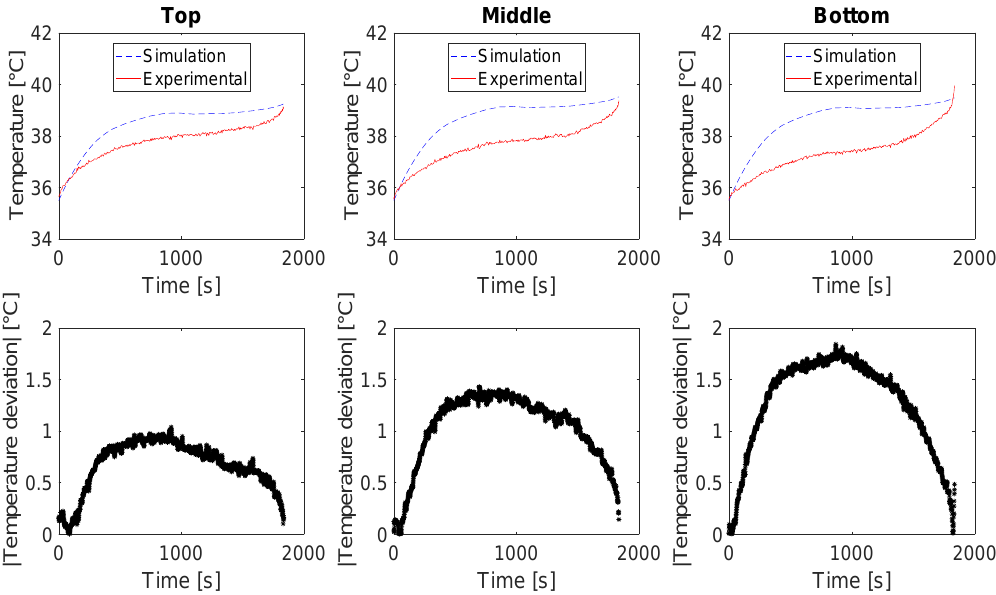
Figure 21. ( Upper ) Uncycled cell surface temperature at three different locations (Top, Middle, Bottom) during high constant current discharge at 35 ◦ C cycling temperature; ( Lower ) Corresponding absolute value of the temperature deviation between experimental and simulations data.